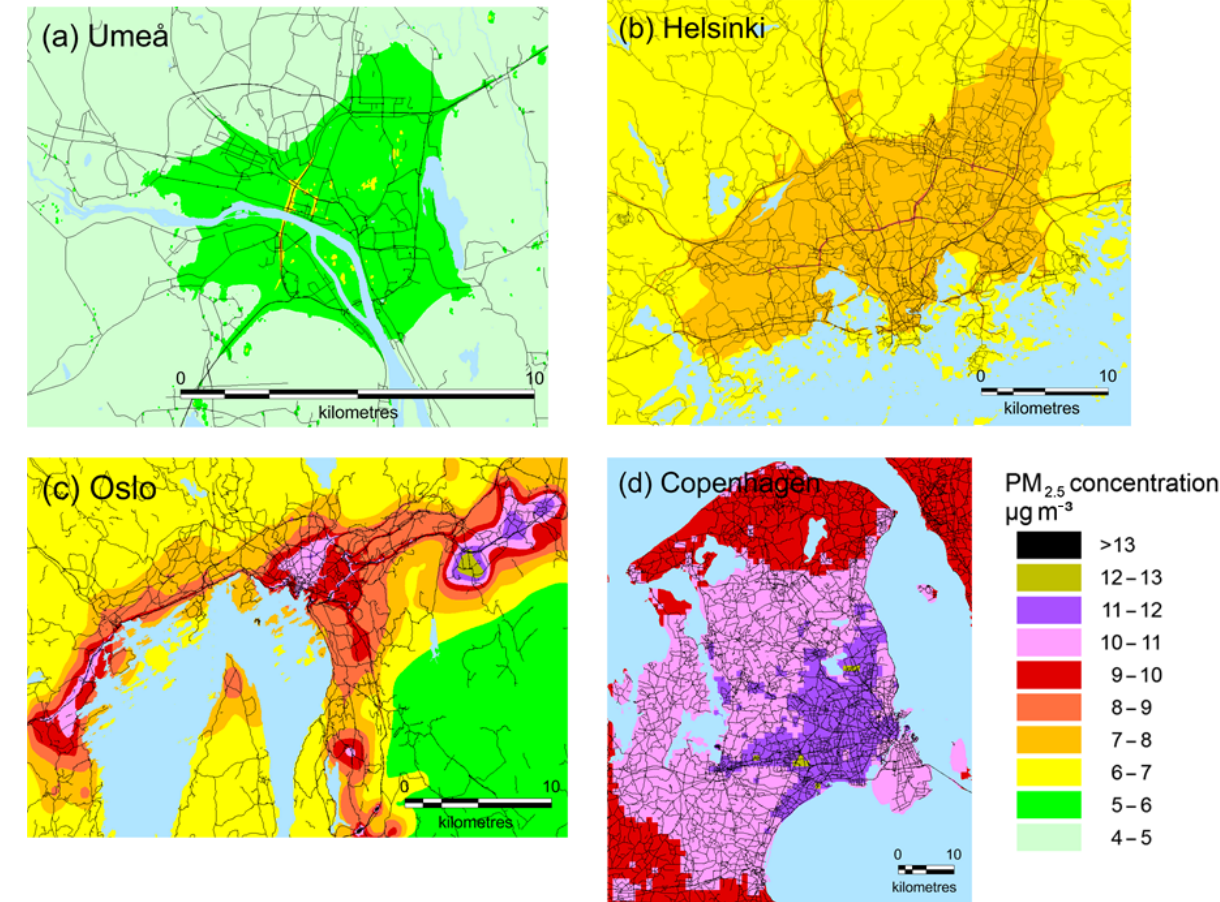
Figure 6. The predicted concentrations of PM 2 . 5 in Umeå (a) , Helsinki (b) , Oslo (c) and Copenhagen (d) . The results represent the year 2011 for Umeå, 2013 for Helsinki and Oslo, and 2014 for Copenhagen. The main road and street networks have been presented as black lines. © OpenStreetMap contributors 2019. Distributed under a Creative Commons BY-SA